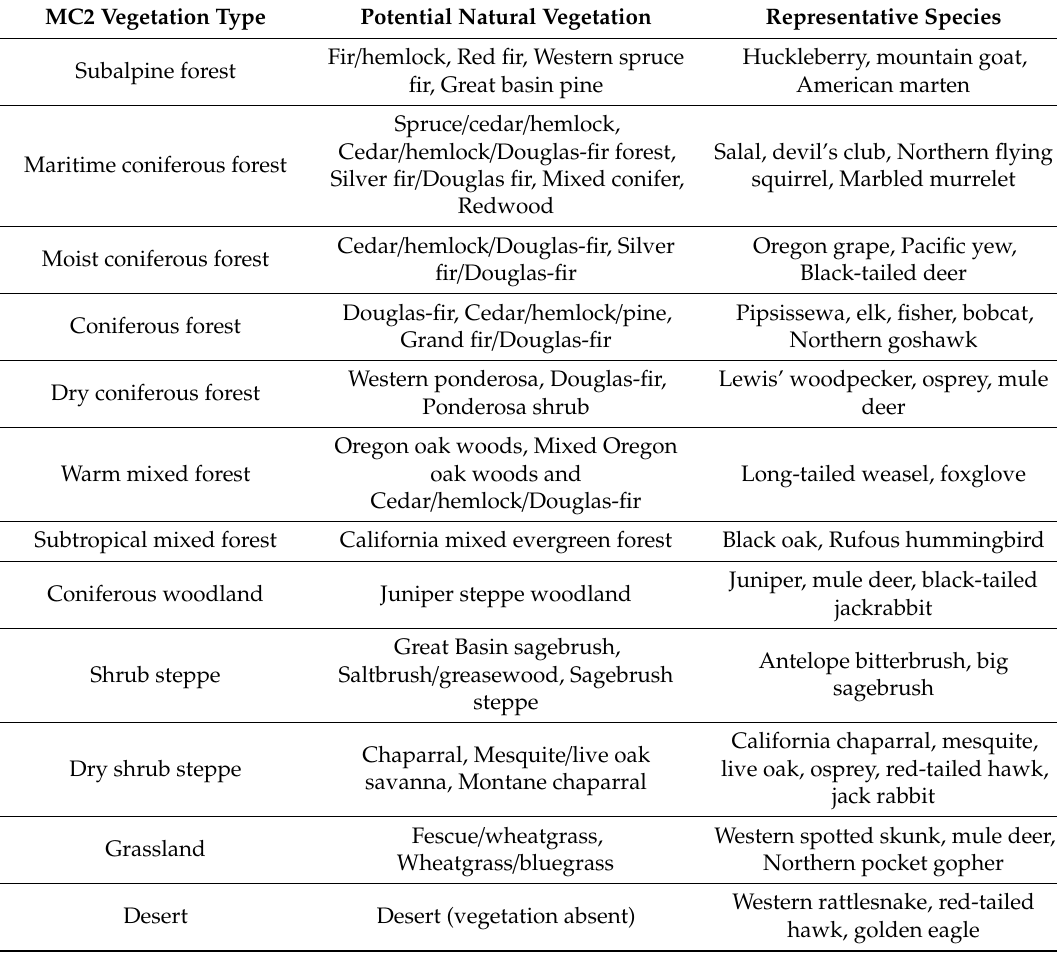
Table 1. MC2 vegetation types and associated potential natural vegetation [46], as identified in [47] and representative